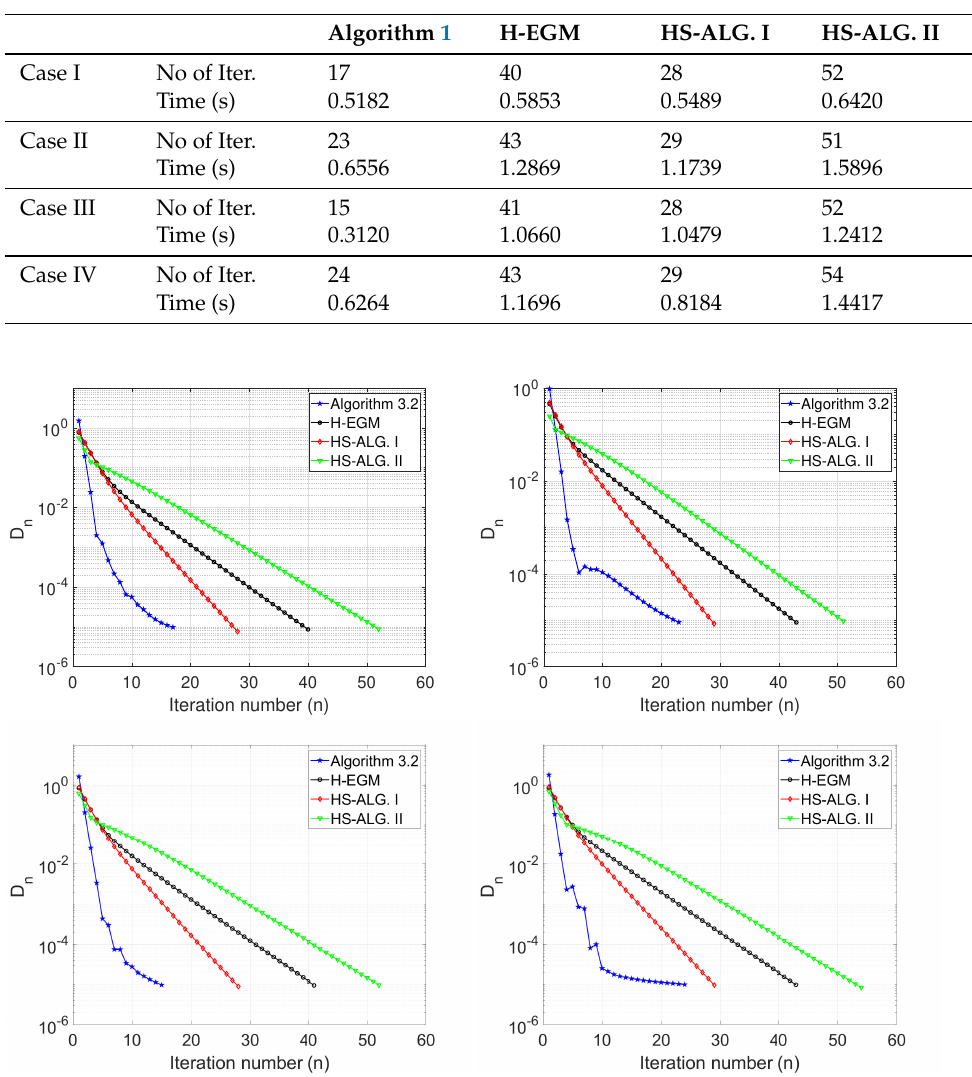
Figure 2. Example 1, Top Left: Case I; Top Right: Case II; Bottom Left: Case III; Bottom Right: Case